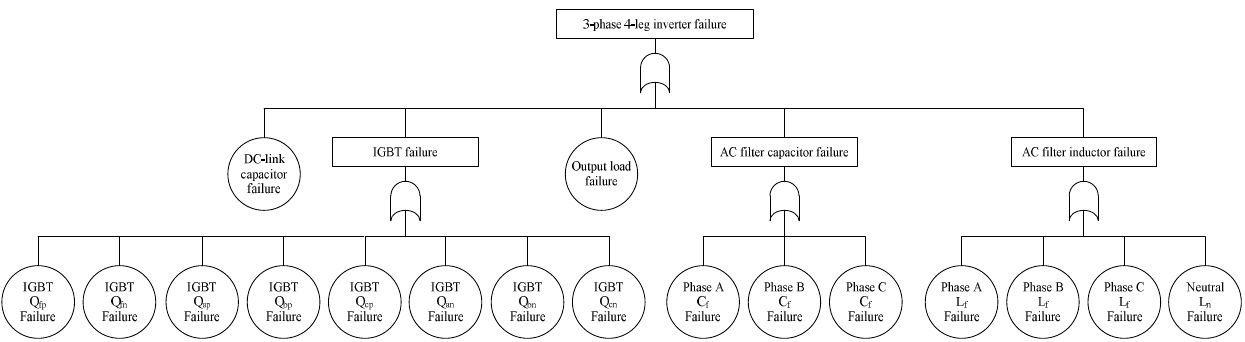
Figure 7. Failure dependency of 4-leg inverter.